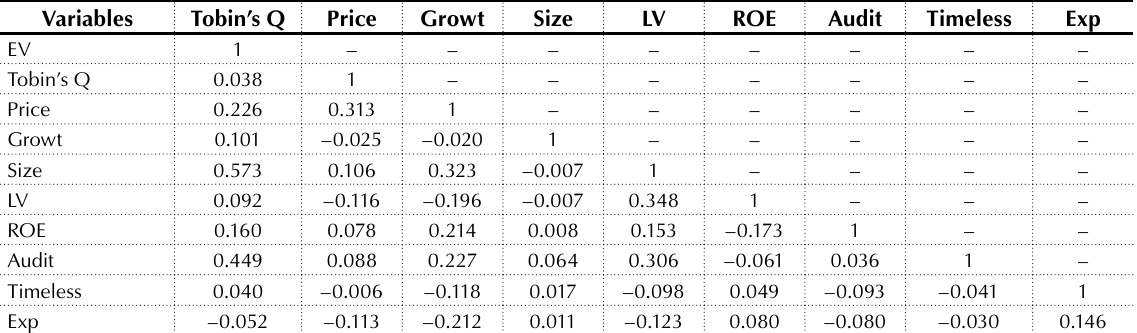
Table 4. Multivariate regression results with dependent variable EV Hypotheses